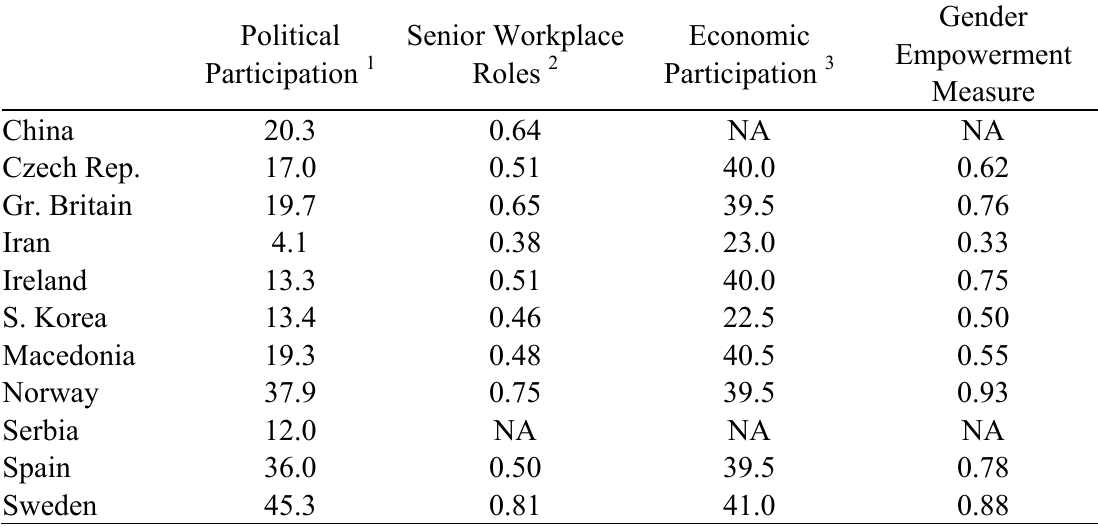
Table 4. Scores for the Gender Empowerment Measure and its different components for each country, (1) Politic Participation (proportion of women in the Lower or Single House in parliament), (2) Senior Workplace Roles (Income, ratio of female to male GDP per capita) and (3) Economic Participation (proportion of women in senior positions: legislators, senior officials, managers, professional workers and technical